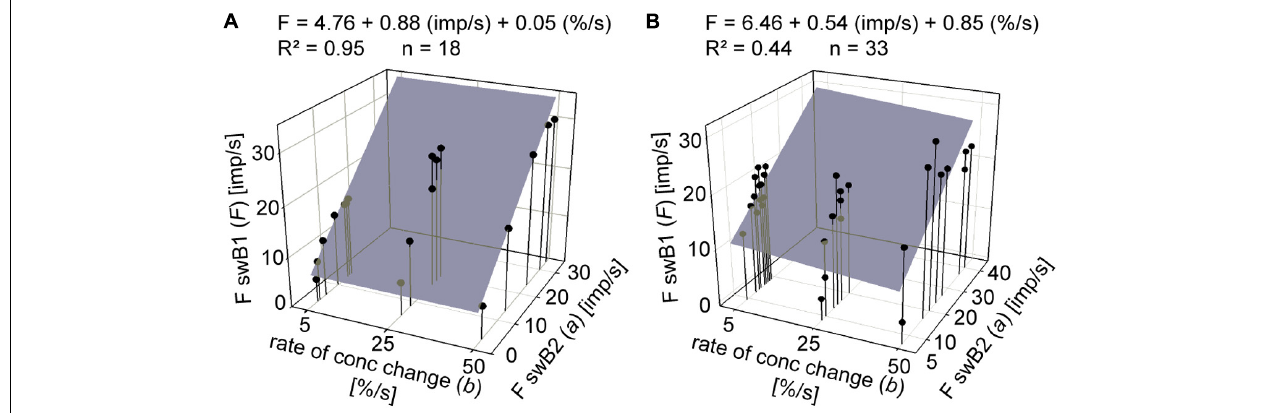
FIGURE 9 | Impulse frequency of swB1 ORN plotted as a function of impulse frequency of swB2 ORN at the same time interval (bin width) for different rates of ramp-like concentration increase. Activity of each swB ORN pair was recorded simultaneously with the same extracellular electrode. (A) Impulse frequencies of the ORN pair shown in Figures 8B,C . (B) Responses of another pair of swB ORNs. Multiple regressions that utilize three-dimensional planes [ F swB1 (imp/s) = y0 + a FswB2 (imp/s) + b (%/s)]; where F is impulse frequency and y0 the height of the regression plane] were calculated to determine the relationship of the response ratio of pairs of swB1 and swB2 ORNs ( a -slope) for different rates of concentration increase ( b -slope). R 2 , coefficient of determination; n , number of points per plot. Bin width for calculating impulse frequency specifies instantaneous concentration and the first derivative, the rate of